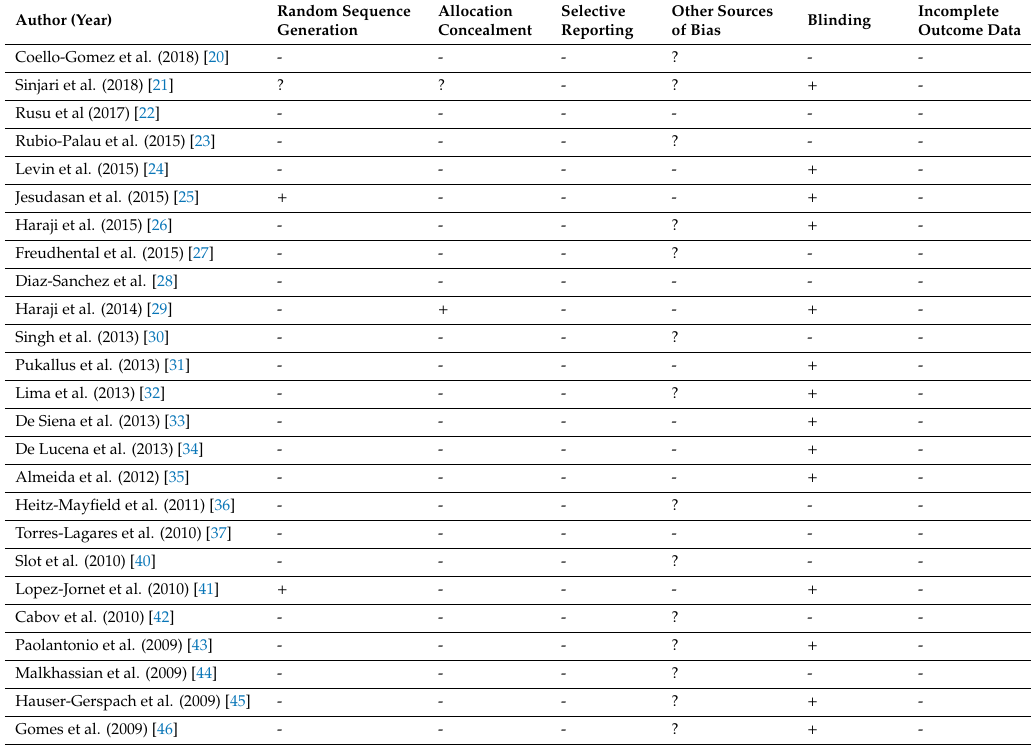
Table 2. Risk of bias table (High + , Low − , Unclear